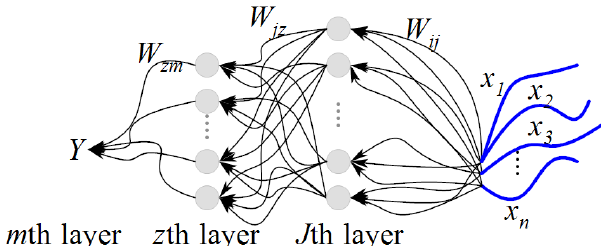
Figure 2. The topology of DNSL (the used parameters are described in the text).